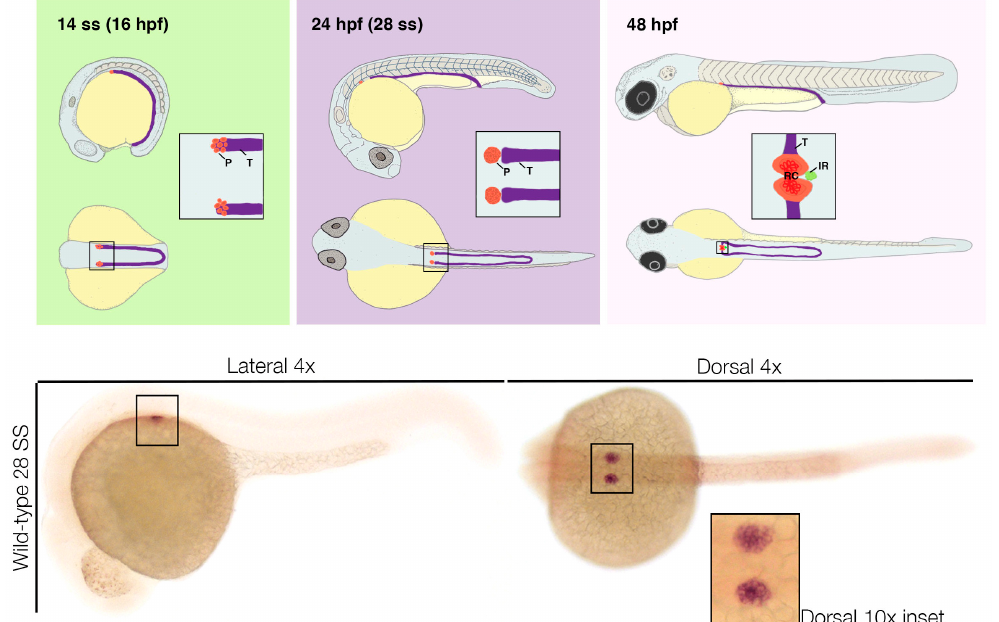
Figure 5. Podocyte development in the zebrafish pronephros. ( top, left ) Podocytes (P) arise from a rostral subset of the renal progenitors, adjacent to the tubule (T) progenitors. ( top, middle ) At 24 hpf, podocyte precursors can be seen as two bilateral clusters of cells, while the two nephron tubules are positioned along the length of the trunk, just dorsal to the yolk sac extension. ( top, right ) By the 48 hpf stage, the podocyte precursors have migrated to the midline, fused, and become associated with vasculature. This event allows for the renal corpuscle (RC) to filter blood and for the pronephros to function. The interrenal gland (IR), an endocrine gland associated with podocytes, has also fused at the midline by this point. ( bottom ) Zebrafish embryo stained using the procedure of whole mount in situ hybridization to visualize the podocytes based on their specific expression of the transcription factor wt1b . Boxed areas in lateral and dorsal views indicate the location of the podocytes